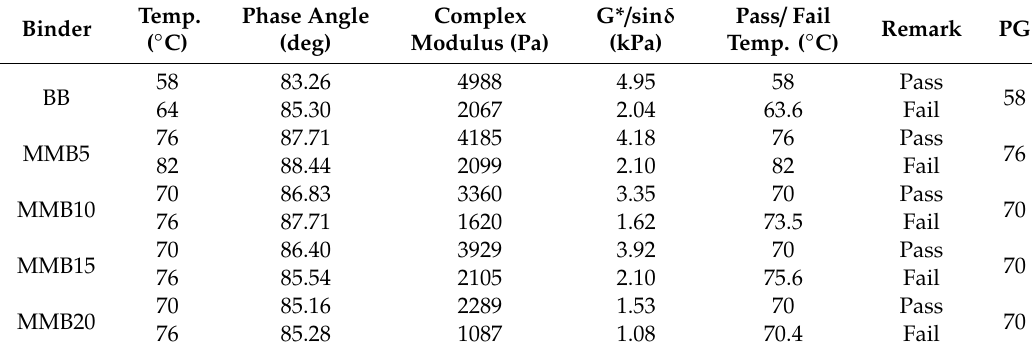
Table 9. Performancegradedetermination test result for rolling thin film oven (RTFO)-aged binders. Binder